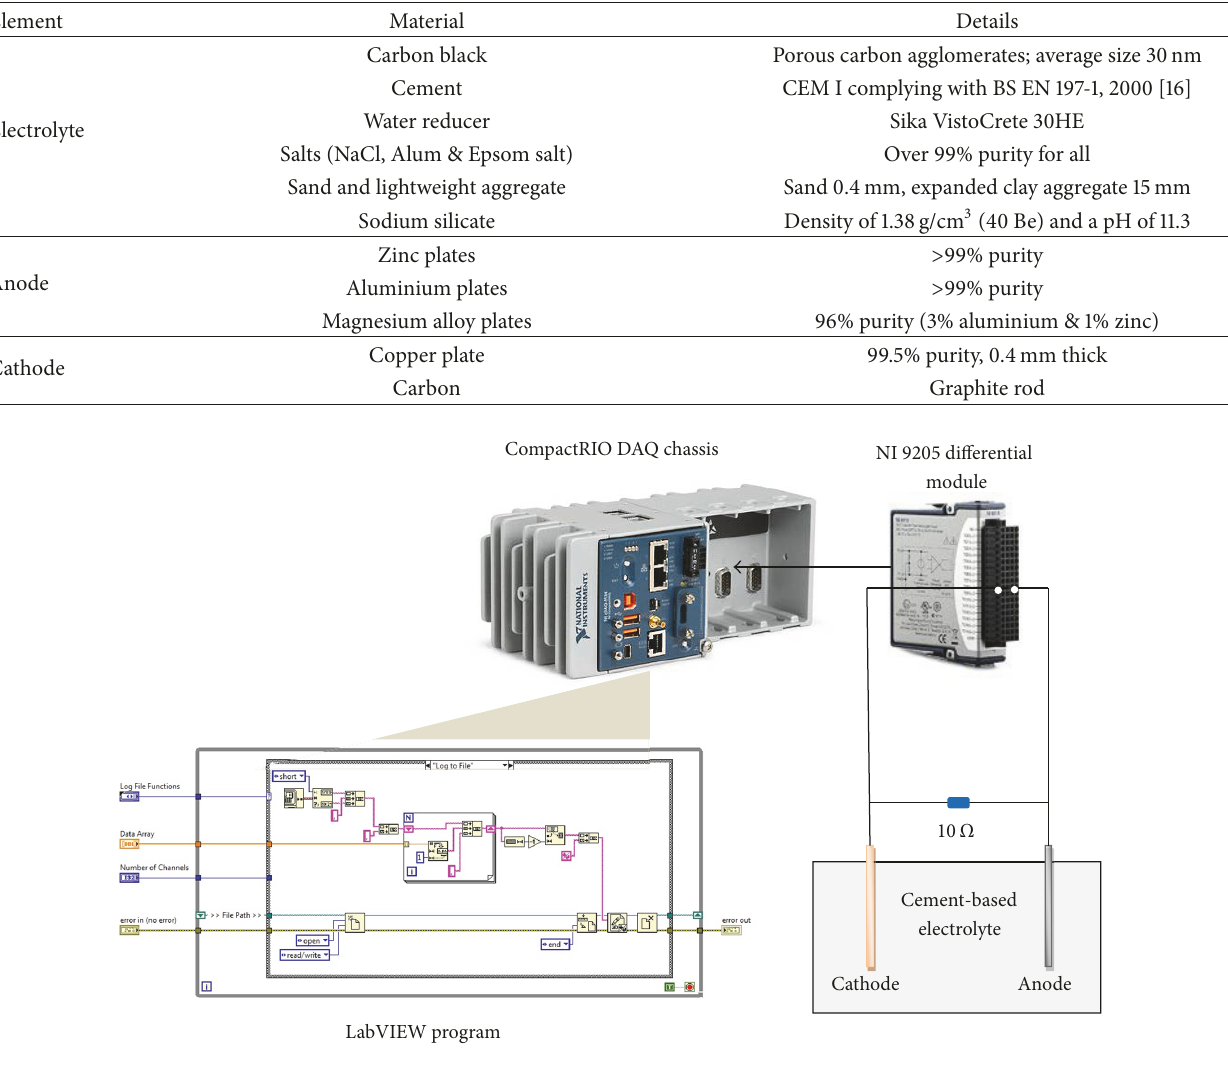
Figure 6: LabVIEW voltage recording across the battery’s 10 Ω resistor